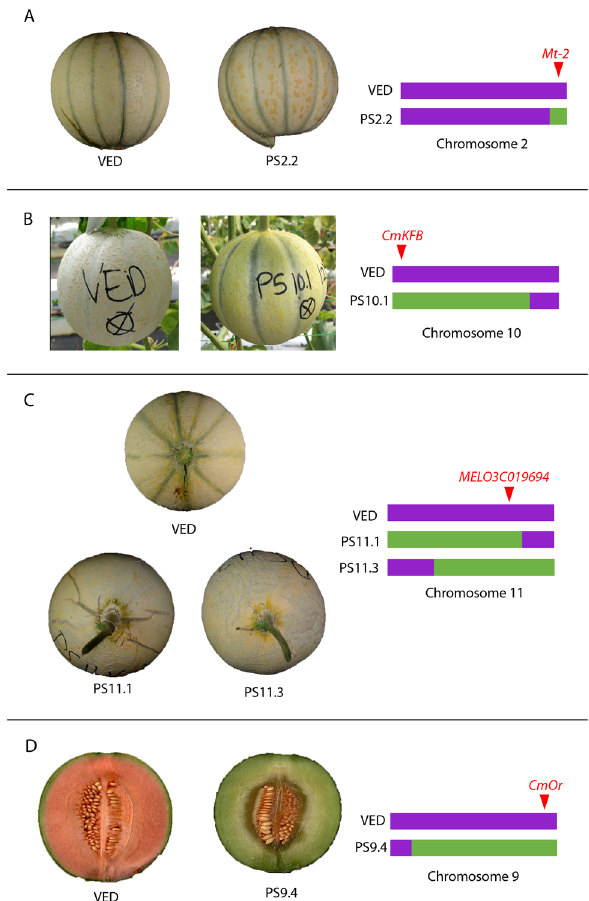
Figure 3. Segregation of qualitative traits and genomic location of the responsible major gene ( A ) Mottled rind ( B ) Yellowing of the rind ( C ) Presence of sutures ( D ) Flesh color of mature fruits.